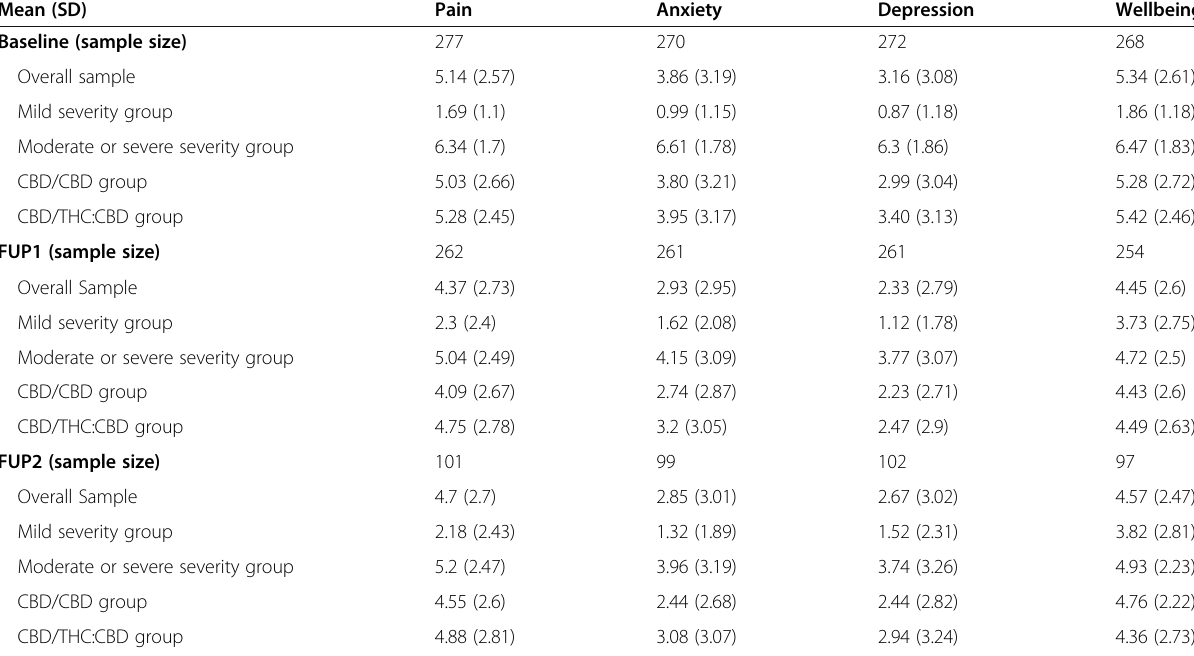
Table 4 Mean and standard deviation (SD) scores of ESAS-r scales for each severity group (mild or moderate/severe) and for each product group (CBD/CBD or